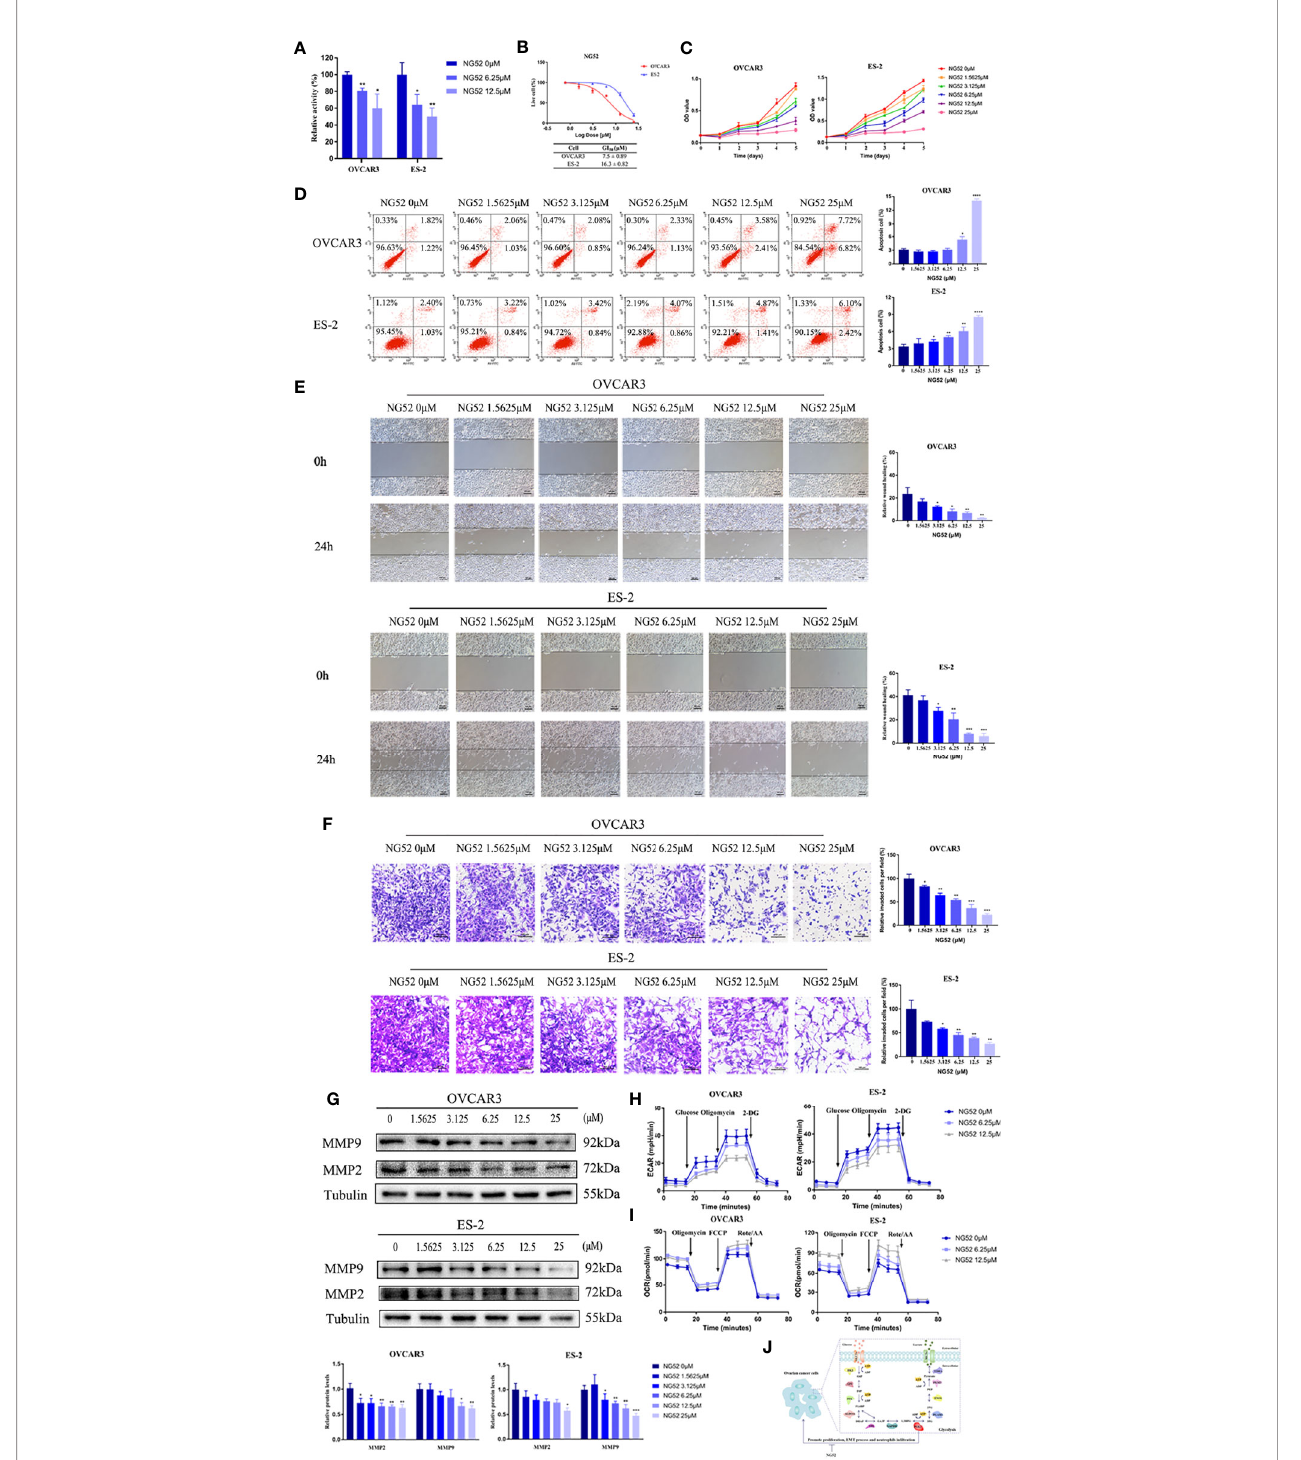
FIGURE 9 | The effect of NG52 on ovarian cancer cells. (A) The effect of NG52 on PGK1 activity. (B) NG52 inhibited the proliferation of ovarian cancer cells in a dose-dependent manner. (C) Time points of NG52 anti-proliferative effects on ovarian cancer cells. (D) NG52 induced apoptosis of ovarian cancer cells. (E) NG52 reduced the migration of ovarian cancer cells. (F) NG52 reduced the invasion of ovarian cancer cells. (G) NG52 decreased the protein expression levels of MMP2 and MMP9. (H) Chart of ECAR measurement in cells treated with NG52. (I) Chart of OCR measurement in cells treated with NG52. (J) Graphical abstract. Error bars represent the mean ± SD of three independent experiments. * P < 0.05; ** P < 0.01; *** P < 0.001, **** P <